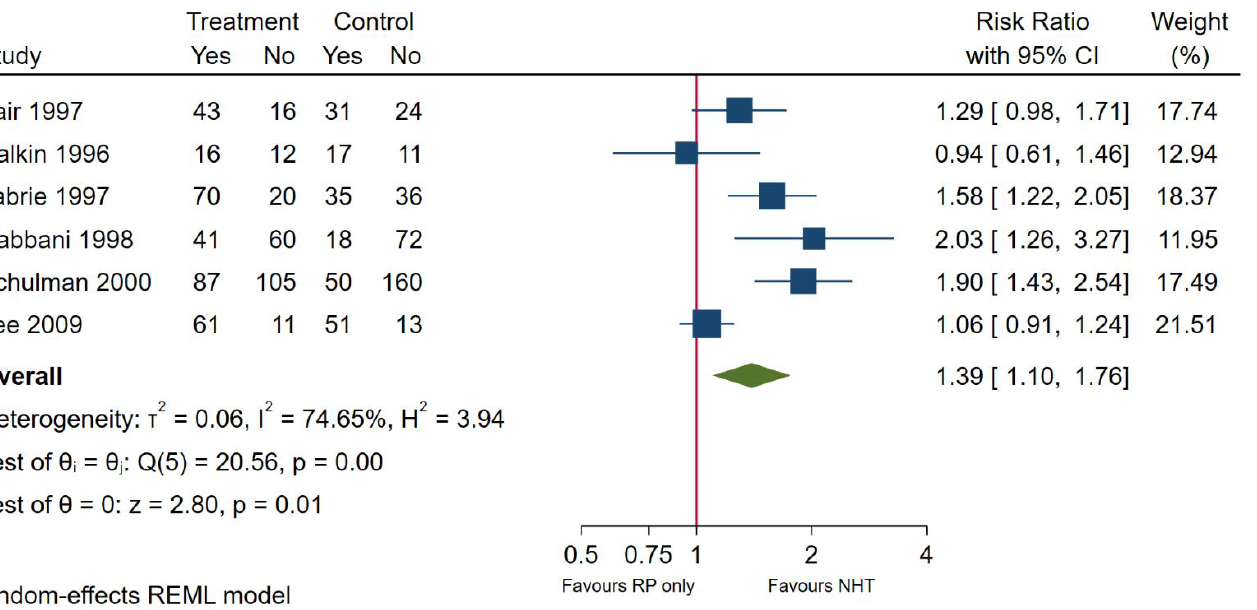
Figure 6. Organ confinement in patients undergoing 3 months NHT followed by RP or RP only.